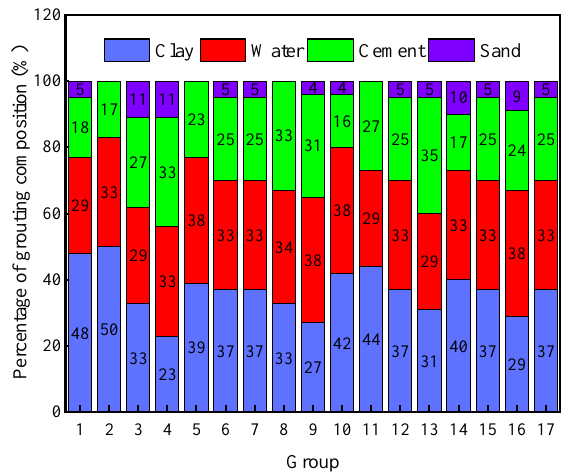
Figure 2. Proportion of each component. Table 7. RSM experimental